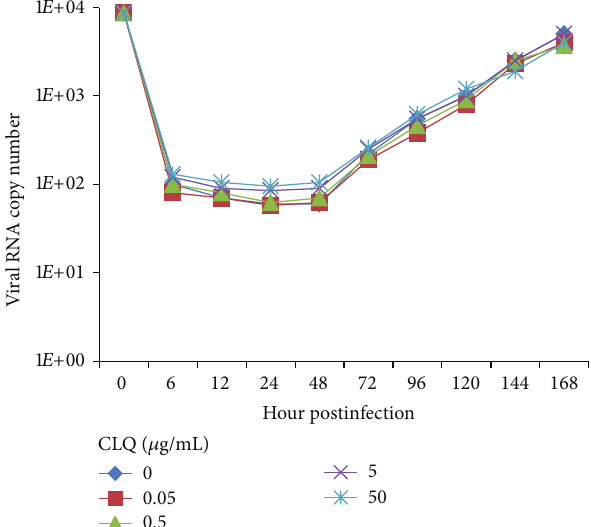
Figure 3: Action of chloroquine on DENV-2 replication in C6/36 cells. The viral RNA present in the culture supernatants of C6/36 cells infected with DENV-2, both untreated and treated with chloroquine just after infection, was extracted and analyzed by qRT- PCR. The results represent the average values of the number of copies of viral RNA ( 𝑃 > 0.05 ).